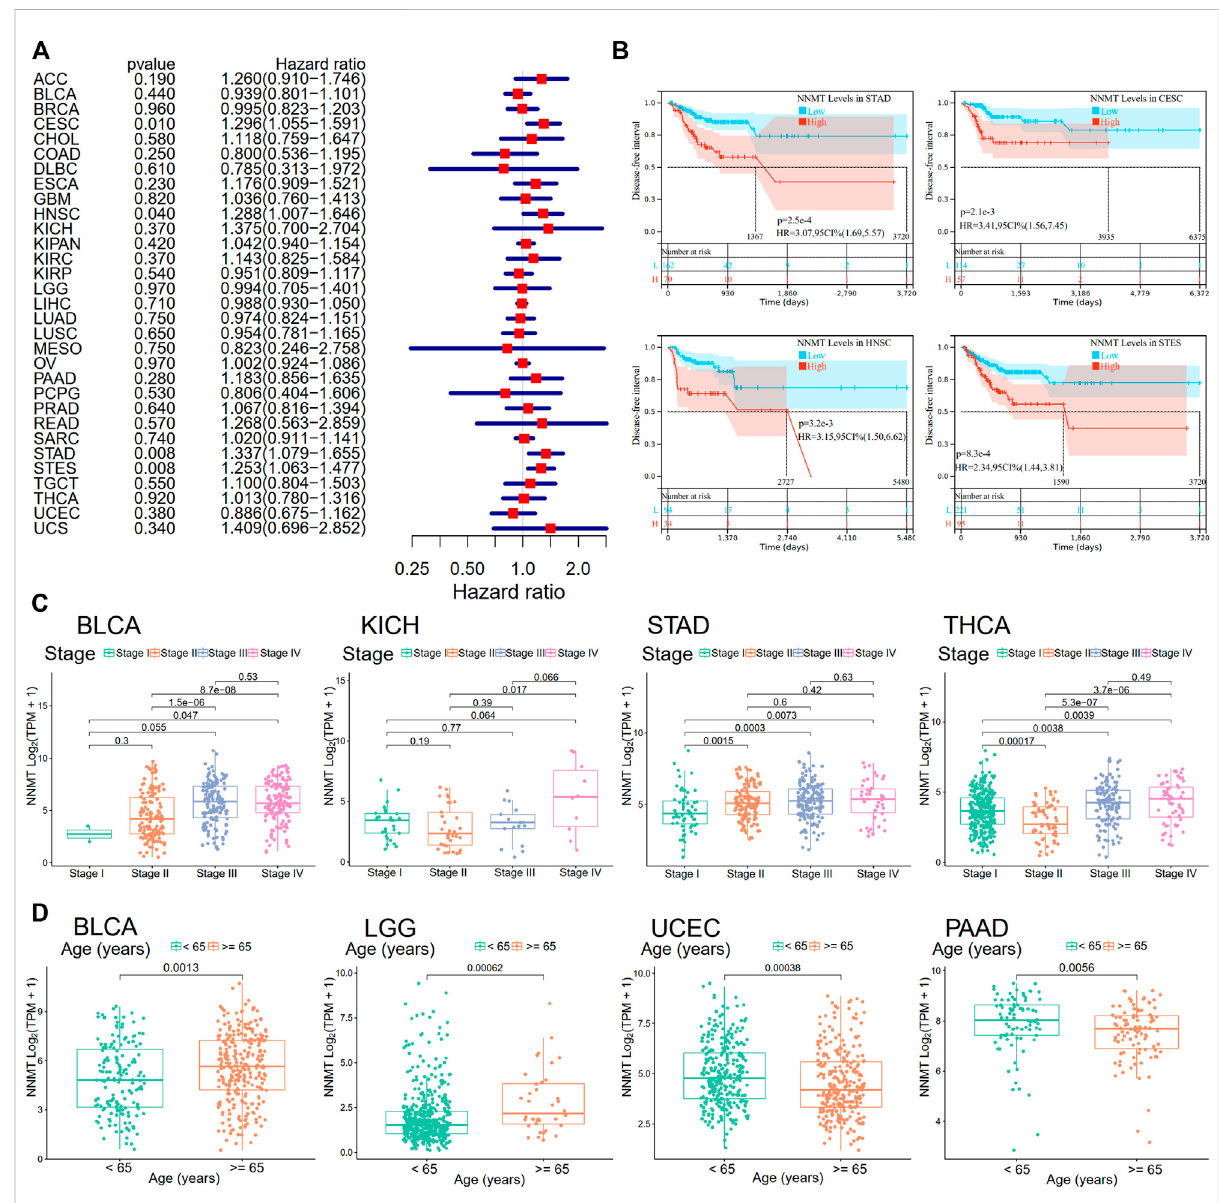
FIGURE 6 Relationship of NNMT expression with disease-free interval (DFI). (A) A forest plot shows the correlation between DFI and NNMT expression in 33 types of tumors. (B) A Kaplan-Meier analysis demonstrating the relationship between NNMT expression and DFI. The link between NNMT expression and pathological stages or age groups, including (C) BLCA, KICH, STAD, and THCA; and (D) BLCA, LGG, UCEC, and PAAD, applying the TCGA